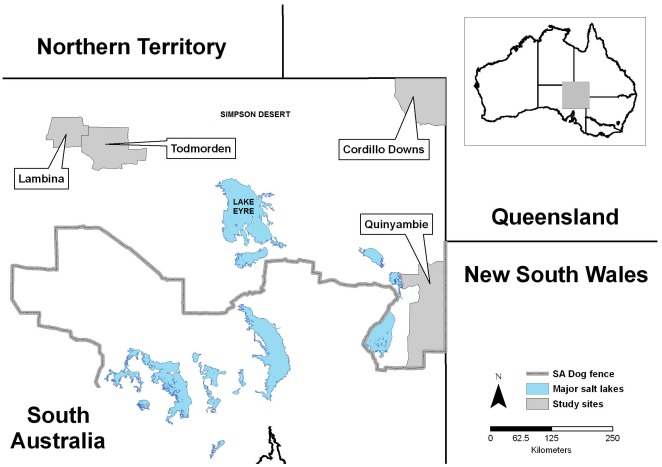
Location of study sites.